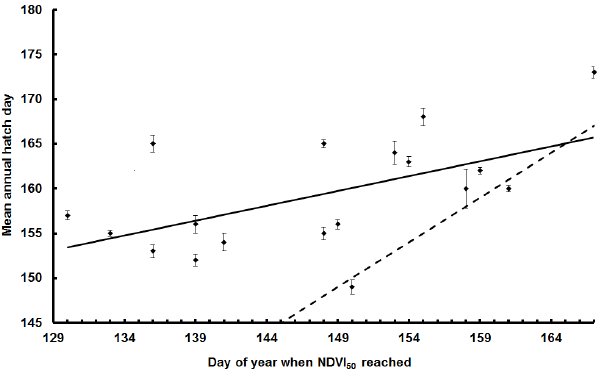
Fig. 2 . Relationship between mean annual hatch day and an index of forage plant phenology. The dashed line represents a 1:1 relationship between hatch timing and forage plant phenology. Bars are 95% confidence